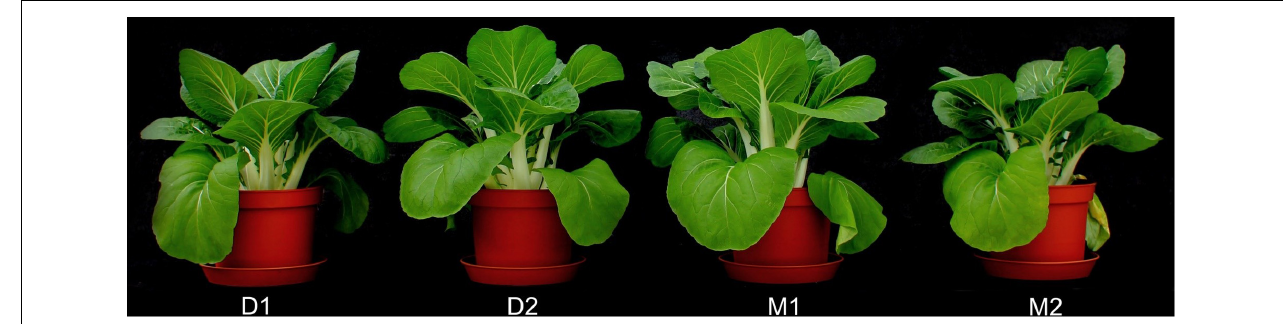
FIGURE 1 | One representative plant from each treatment at harvest. D1, digestate; D2, digestate with amendments; M1, mineral nutrient solution designed to have the same nutrient composition as D1; M2, mineral nutrient solution designed for optimal growth. TABLE 4 | Nutrient uptake efficiency of phosphorous (P) and sulfur (S) (PUE and SUE), calculated as the ratio of nutrients taken up by crop (content in shoots) to fertilizer nutrients applied ( n = 4 ± SD). Treatment Total amount applied Total shoot PUE and SUE,% Concentration in shoots PUE D / M and (mg/plant) uptake (mg/plant) at harvest (g/kg) SUE D /